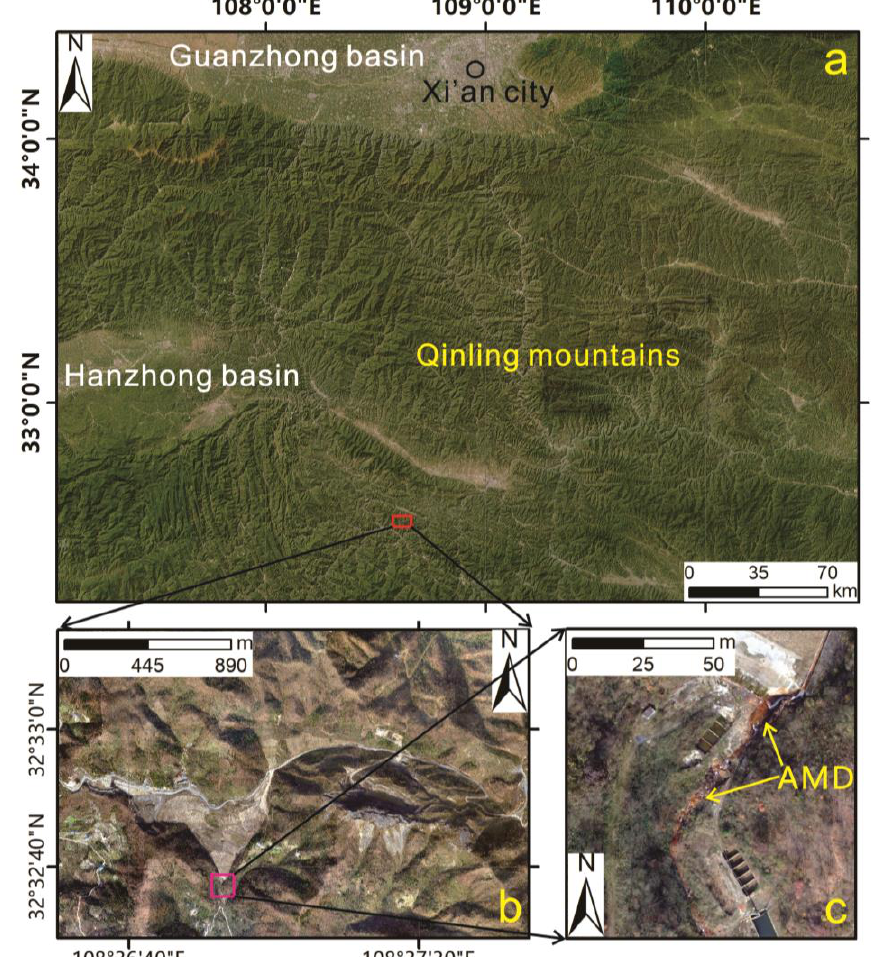
Figure 1. ( a ) Location of the stone coal mining area; ( b ) UAV image of the study area; ( c ) the Xiaomi stream polluted by AMD.